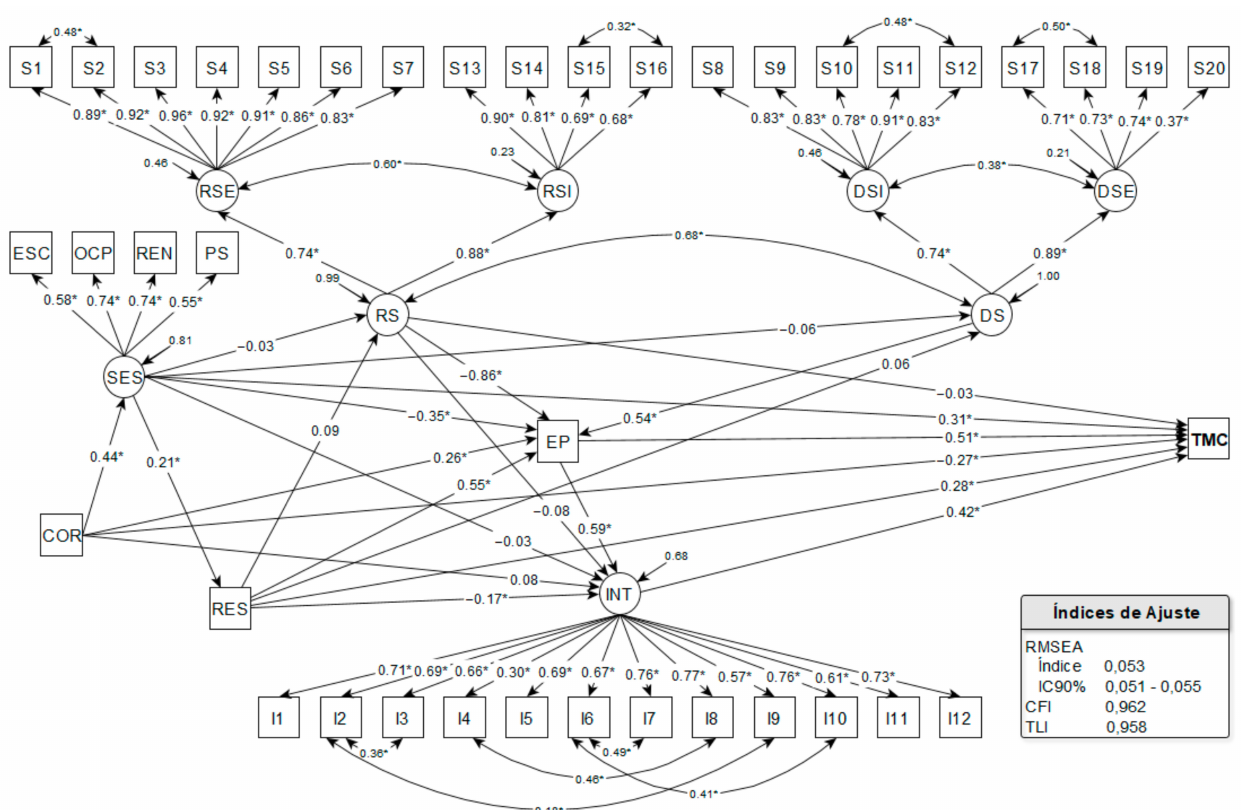
Figure 2. Structural equation model with direct and indirect specific effects for CMDs among Brazil- ian men in the COVID-19 pandemic context. Brazil, 2020. SES, socioeconomic status; INT, intolerance to uncertainty (I1–I12: indicating variables); RES, receiving emotional support (S1–S7: indicating variables); RIS, receiving instrumental support (S13–S16: indicating variables); OIS, offering instru- mental support (S8–S12: indicating variables); OES, offering emotional support (S17–S20: indicating variables); RS, receiving support; OS, offering support; SCH, schooling; OCP, occupational status; INC, monthly income; HP, use of health plan; COL, race/skin color; HS, house-sharing; PS, perceived stress; I1–I12, items 1 to 12; S1–S20, items 1 to 20; RMSEA, Root Mean Square Error of Approximation; 90%CI, 90% confidence interval; CFI, Comparative Fit Index; TLI, Tucker–Lewis Index. * Statistically significant loads ( p -value <